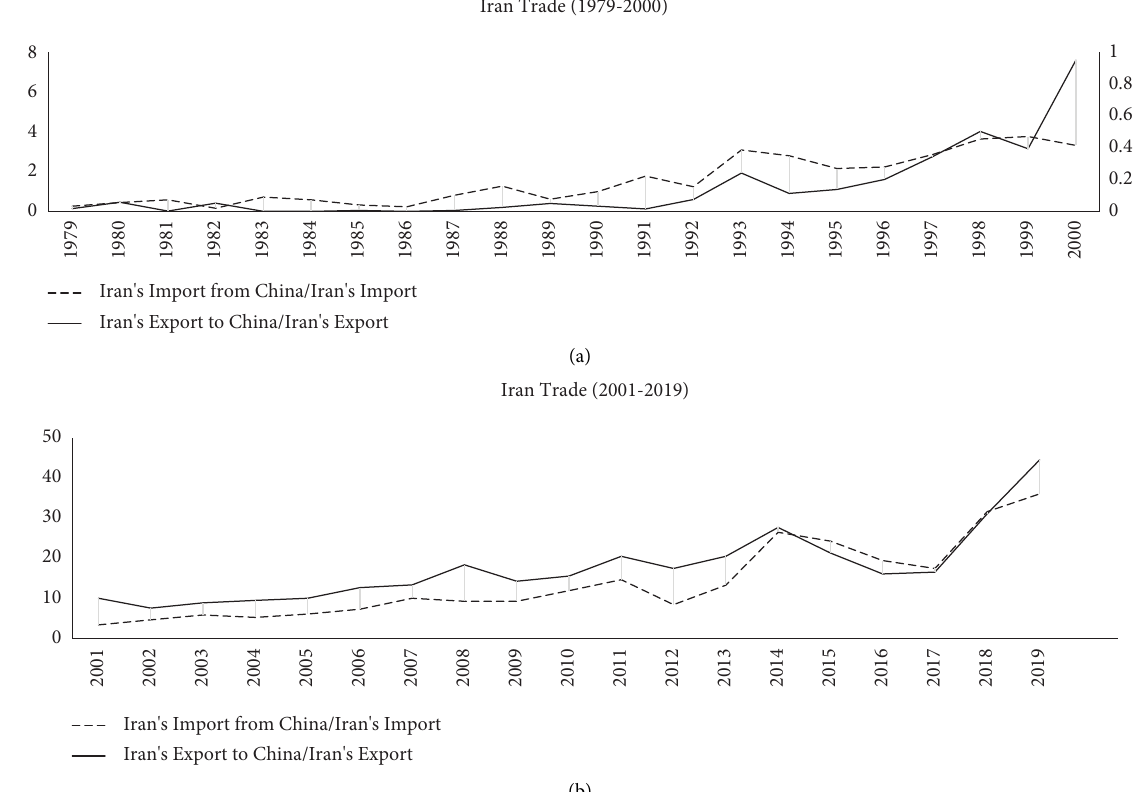
Figure 4: Share of Iran’s trade with China in Iran’s total trade (1979–2019). Source: the IMF direction of trade statistics [23]. (a) 1979–2000. (b)